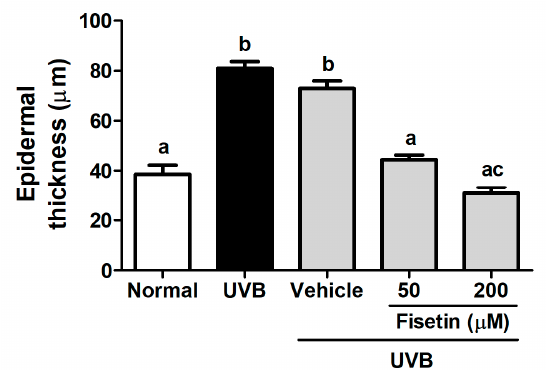
Figure 5. Effects of fisetin on the epidermal thickness of the UVB-irradiated hairless mice in the 10th week. a–c: Values not followed by a common letter are significantly different ( p < 0.05).